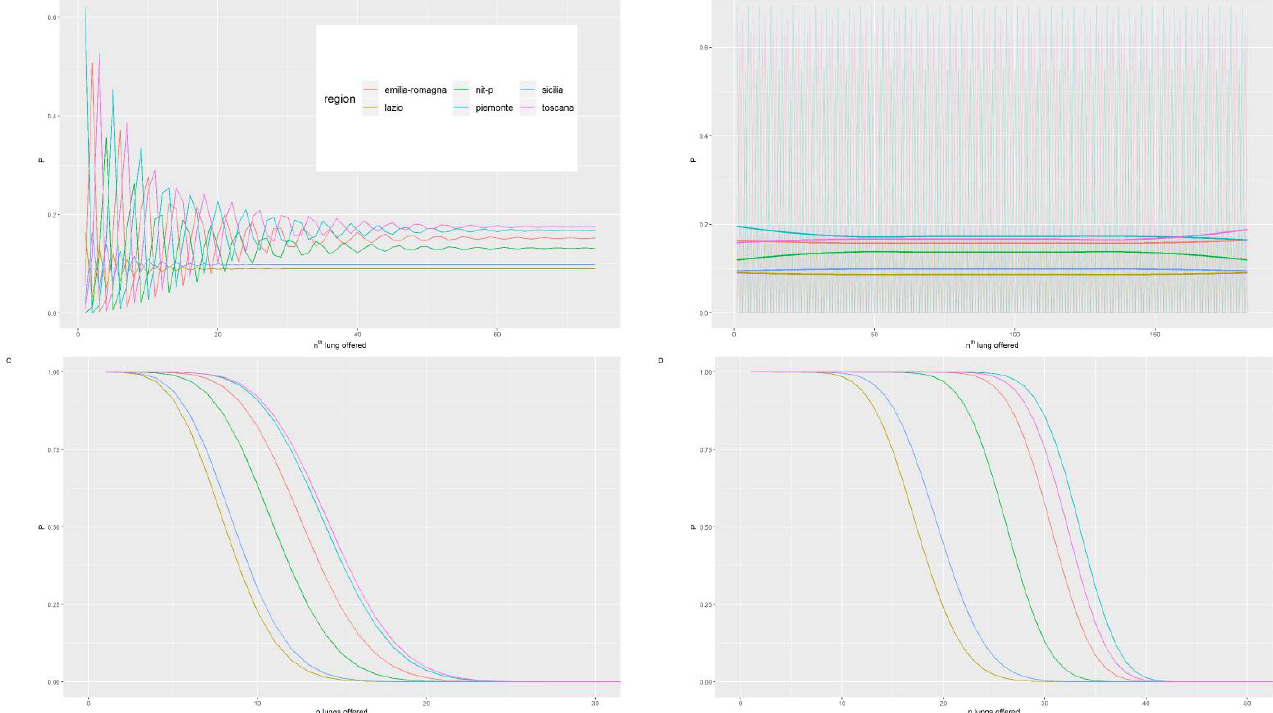
Figure 5. Panels ( A , B ) show trends of the probability for the n-lung to be offered and accepted by each region as the number of lungs donated increases with acceptance rates of 90 and 100%, respectively, in 2015. Panels ( C , D ) are the trend of the probability that at least n-th lung will be offered and accepted by each region as the number of lungs donated increases with acceptance rates of 90 and 100%, respectively, in 2015. In the background of panel B at the top, the trend of the probabilities can be observed, while the thicker lines depict the average of the probabilities for each CRT.